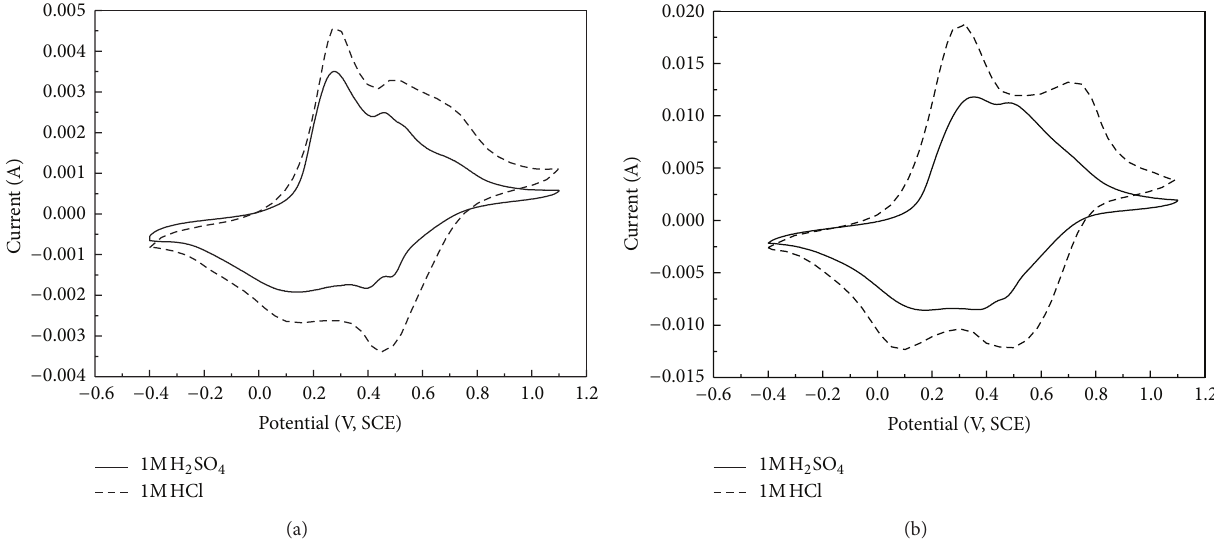
Figure 7: Cyclic voltammograms of PANI in different acid electrolytes at the same potential scan rate ((a) 10mVs −1 , (b) 50 mVs −1 ).